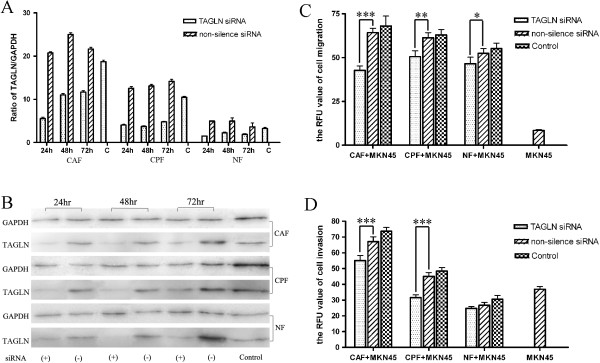
CAFs enhance tumor cell line MKN-45 migraton and invasion through upregulated TAGLN. A: TAGLN expression by QRT-PCR analysis after siRNA knockdown in fibroblasts. B: TAGLN expression by Western blot analysis after siRNA knockdown in fibroblasts. C: cell migration assay in vitro (fibroblasts with or without TAGLN siRNA interference). D: cell invasion assay in vitro (fibroblasts with or without TAGLN siRNA interference). Values represent the mean ± SD from at least three separate experiments, each conducted in triplicate. *, P < 0.05, **, P < 0.01, ***, P < 0.001, by one-way analysis of variance (ANOVA).